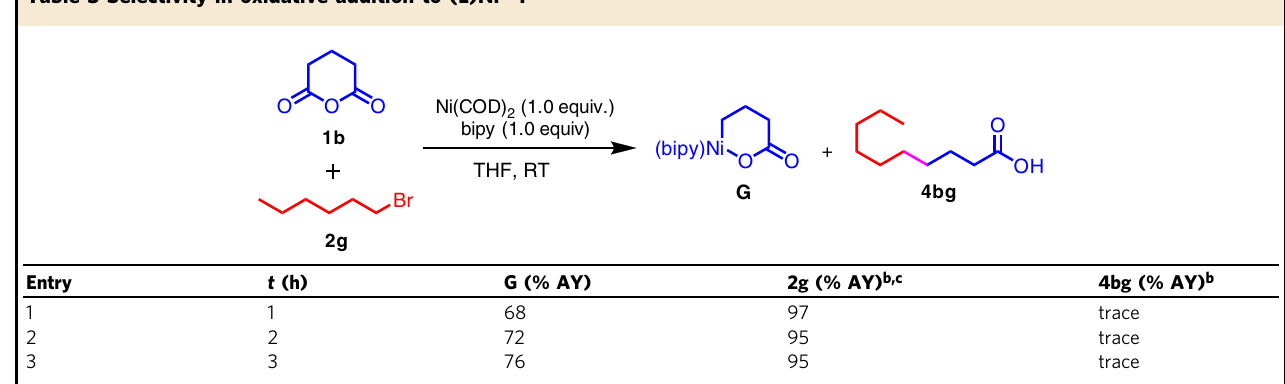
Table 3 Selectivity in oxidative addition to (L)Ni 0a .